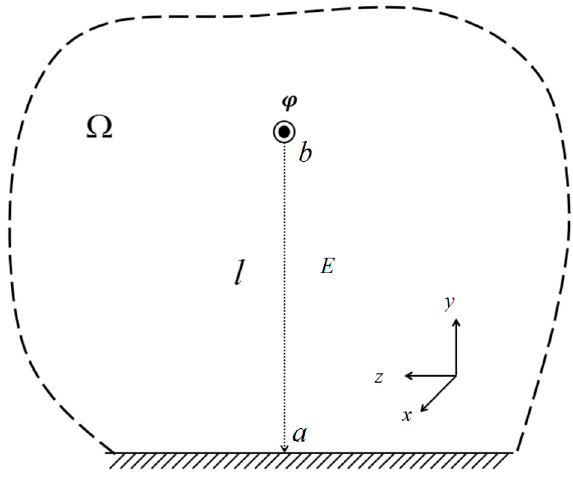
Figure 4. Integral paths.